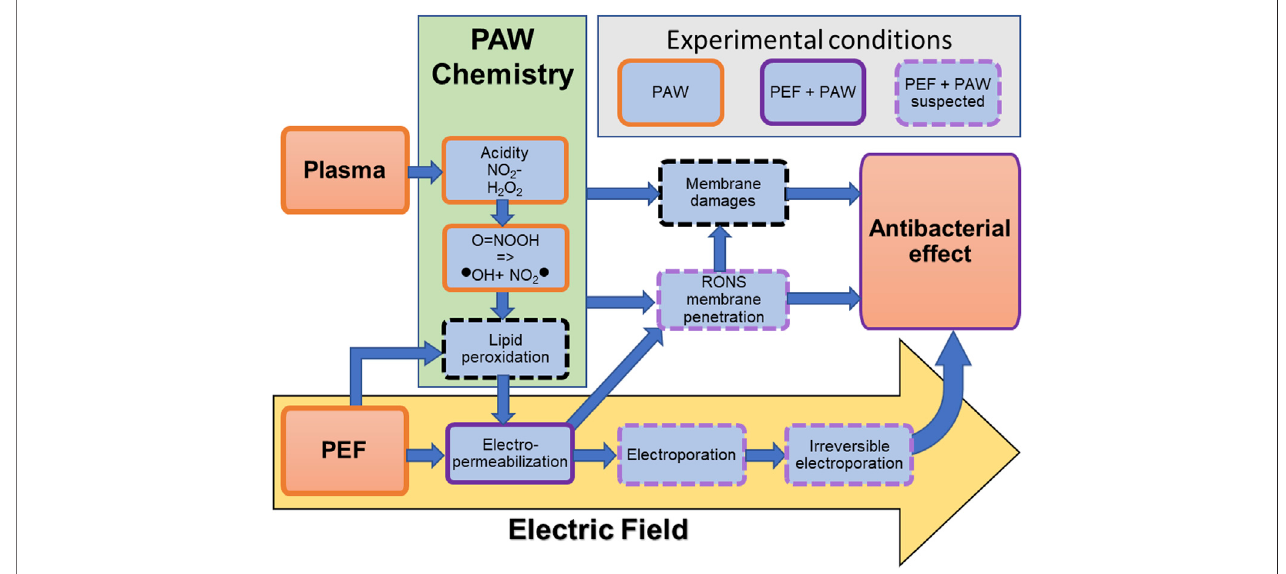
FIGURE 10 | Summarizing schematics of the interaction between NO − 2 and H 2 O 2 and bacterial incubation in PAW reinforced by the PEF treatment.